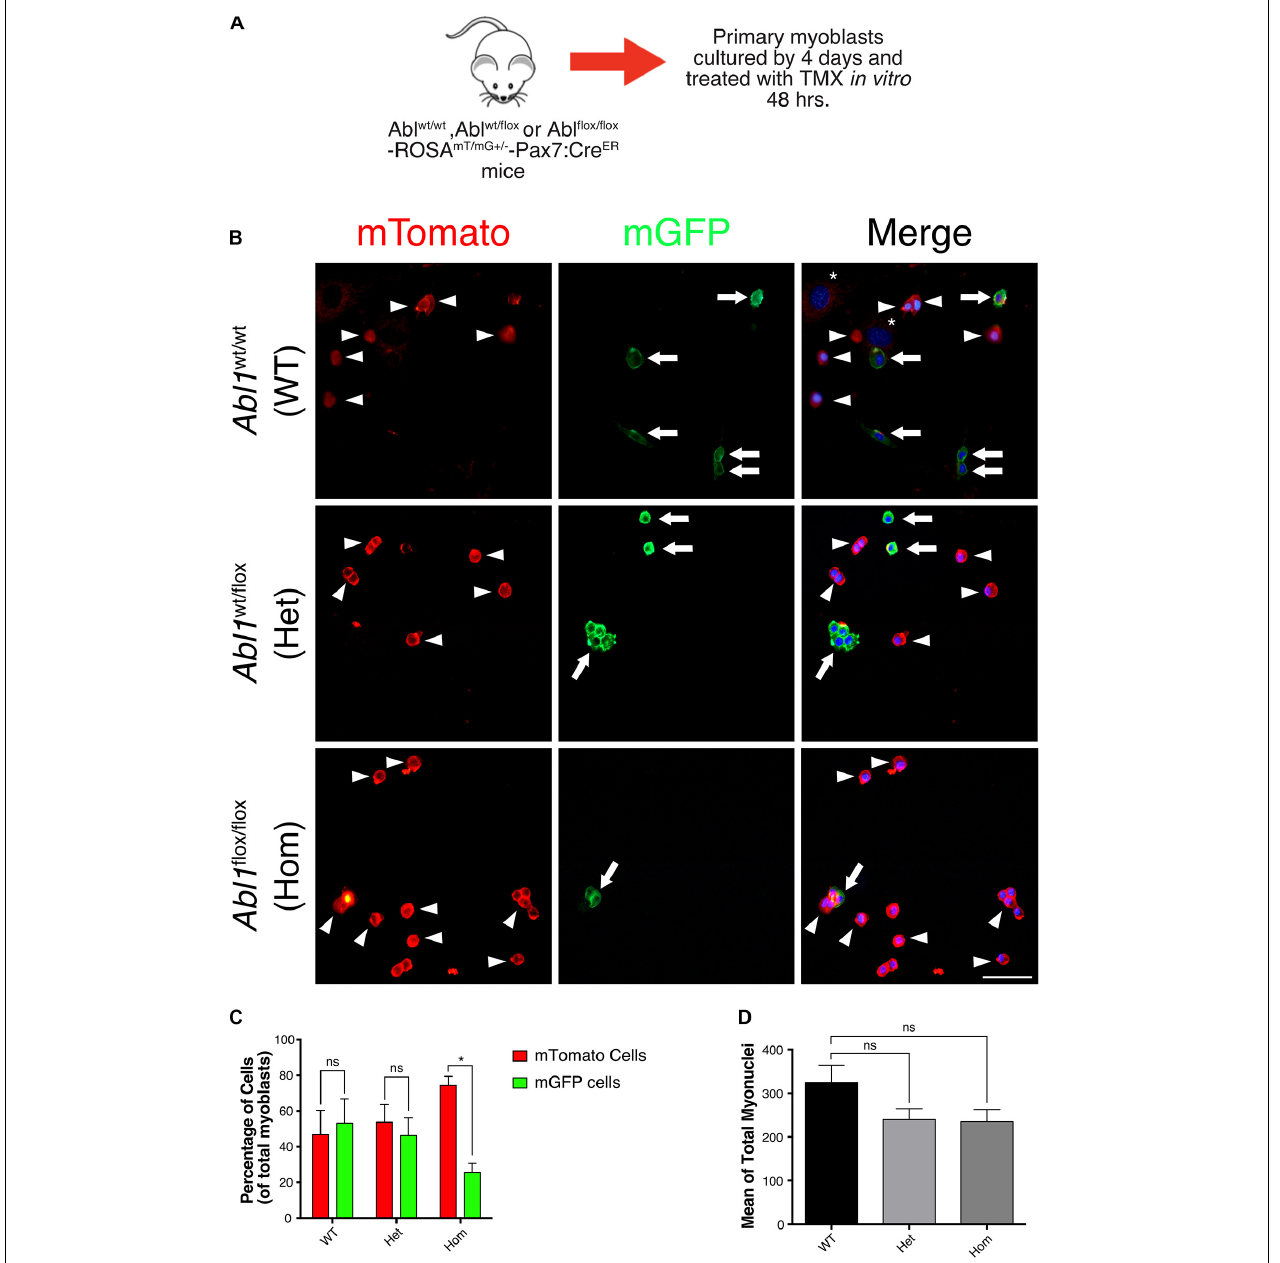
FIGURE 7 | GFP positive primary myoblasts population decrease in c-Abl Knockout cells recombined in vitro . (A) Protocol to induce Abl1 recombination in vitro . Primary myoblasts were isolated from Abl1 WT / WT (WT), Abl1 wt / flox (Het), or Abl1 flox / flox (Hom) ROSA mT / mG -Pax7 creERT2 mice and maintained 4 days in PM. During this time, cells were treated with vehicle or Tamoxifen (TMX, 10 µ M) for 48 h. After that, cells were fixed, and direct fluorescence was detected. Nuclei were stained with Hoechst 33342 (blue). (B) Arrowheads show mTomato positive cells and arrows show mGFP positive cells. The asterisk shows non-myogenic cells. Scale bar: 50 µ m. (C) Quantification of the percentage of mTomato positive and mGFP positive myoblasts from (B) ( n = 3, * P -value < 0.05, multiple t -Student test, ns, not significant). (D) Total number of myoblasts do not change in different mice. Mean of total myoblasts was determined for every mouse from (B) . WT mean: 324.5 ± 39.50; Het mean: 239.7 ± 25.06; Hom mean: 234.7 ± 28.30 ( n = 3, P -value > 0.05, ANOVA test, ns, not